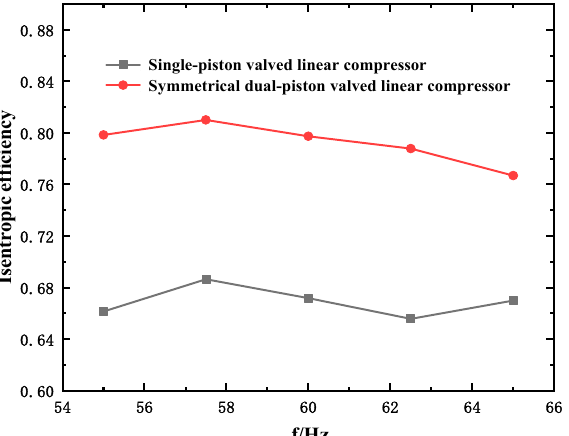
Figure 16. The isentropic efficiencies of the two types of linear compressors at different frequencies, obtained from the experiments.